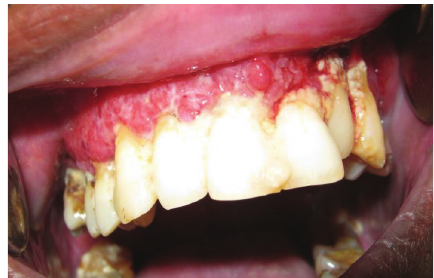
Figure 2: Involvement of labial mucosa and gingival hypertrophy with bleeding.